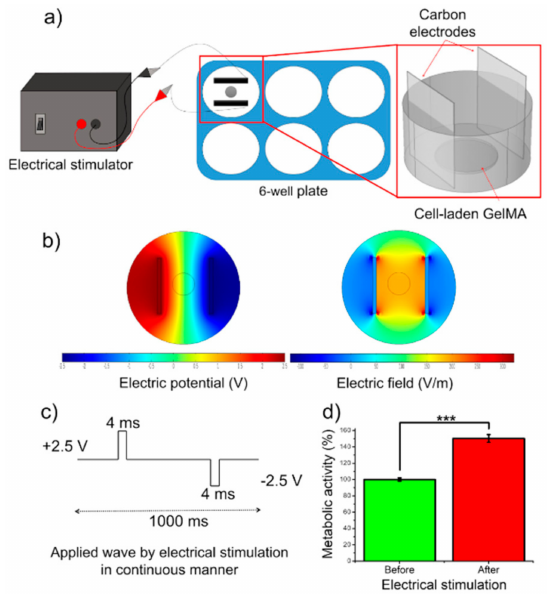
Figure 7. E ff ect of electrical stimulation on C2C12-laden GelMA bioinks. ( a ) Schematic of electrical stimulation setup. ( b ) Numerical simulation of applied electrical pulse. ( c ) Wave form used to stimulate cells. ( d ) Metabolic activity of C2C12 cells in GelMA bioinks before and after electrical stimulation (*** p <